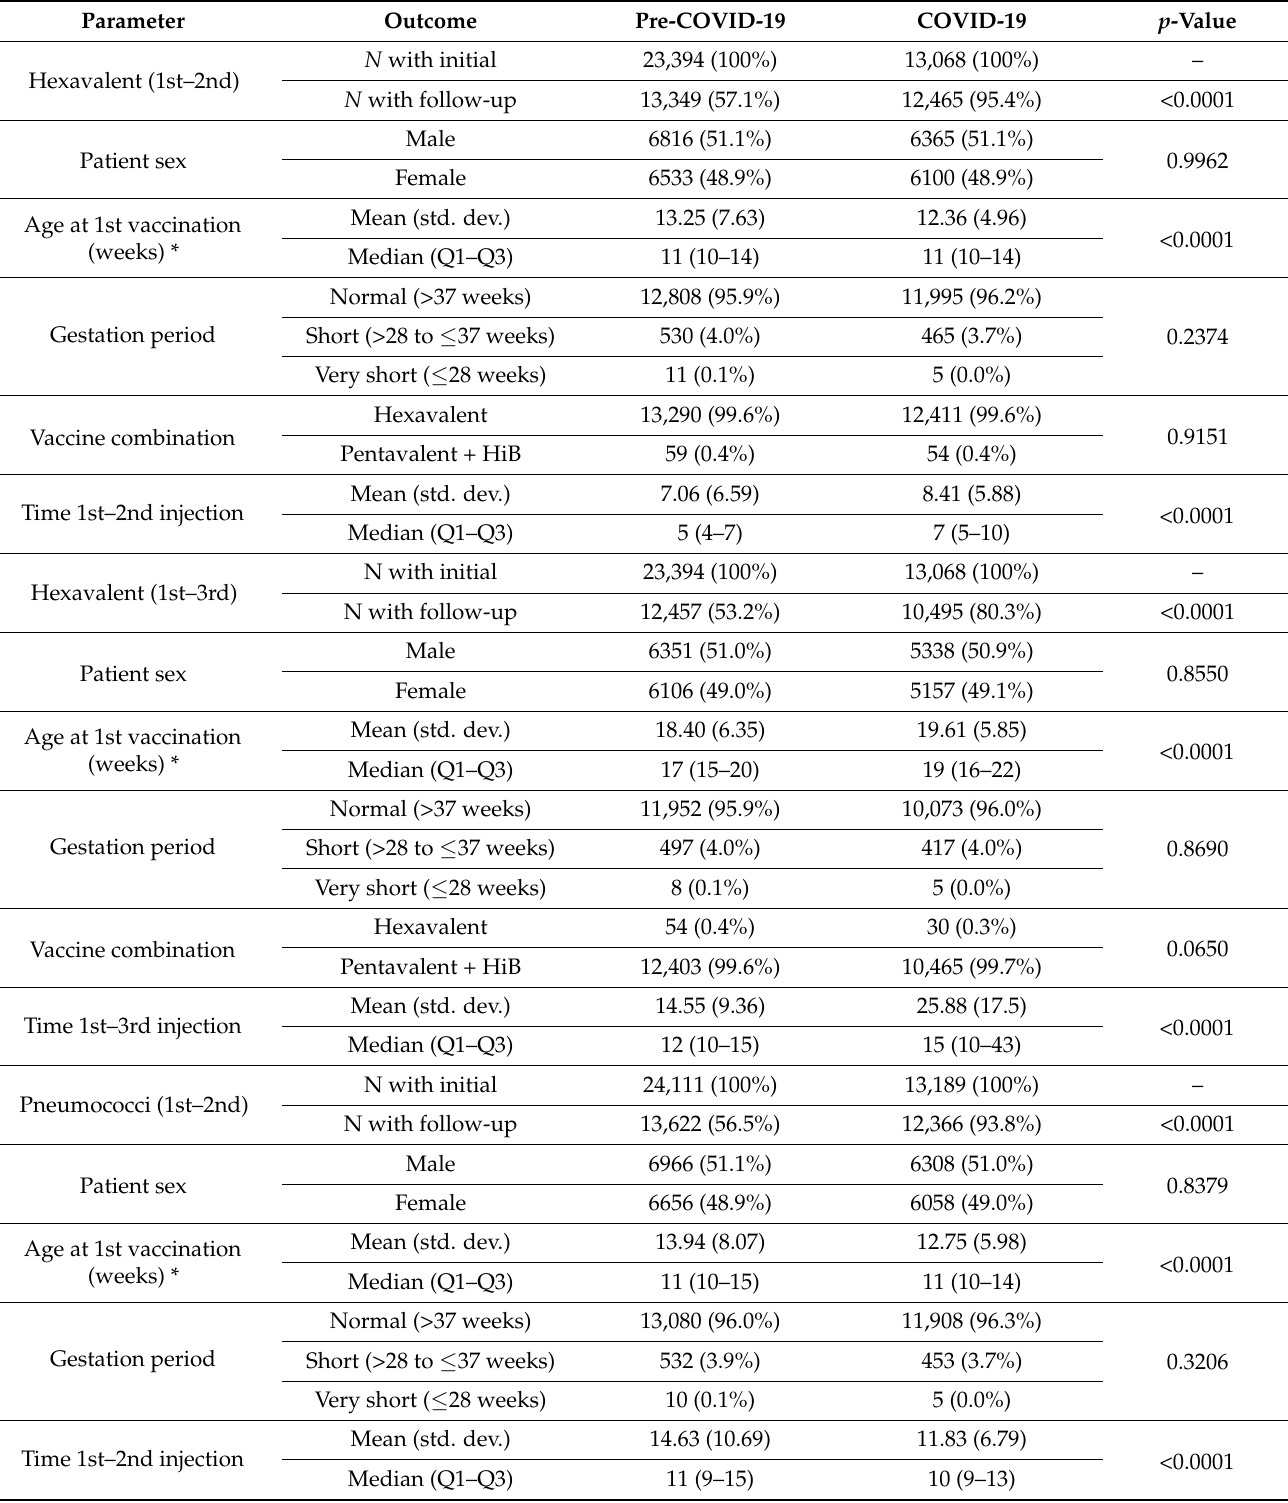
Table 4. Results of the analysis of paediatric vaccinations for each pair of initial and follow-up events. Percentages of N with follow-up are given in relation to N with initial event. For other categories, the percentages are in relation to N with